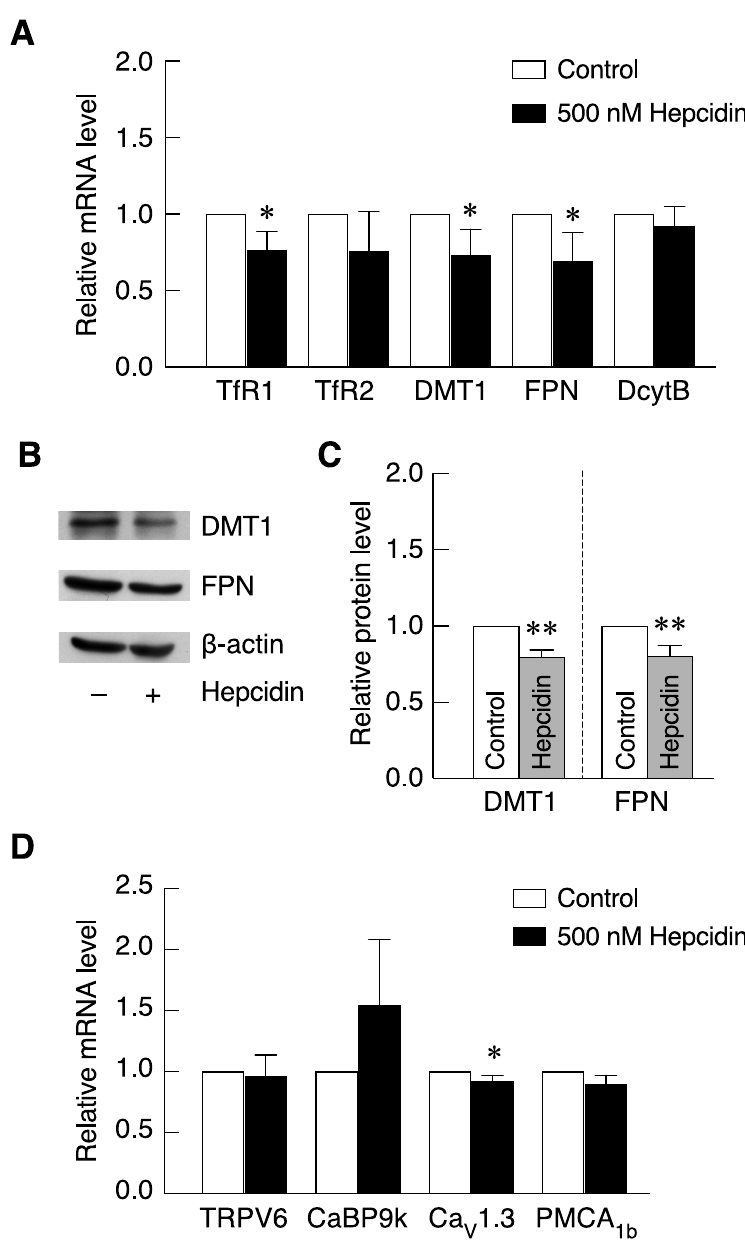
Fig 3. Hepcidin decreased DMT1 and FPN at mRNA and protein level but did not alter most calcium transporter and calcium binding protein expression at mRNA level. mRNA and protein expression of iron transporter and iron transport-associated proteins in Caco-2 cells after exposed to 500 nM hepcidin for 24 hours. ( A ) mRNA level was investigated by qRT-PCR and normalized by GAPDH and control groups (n = 3). ( B ) DMT1 and FPN protein expression was determined by western blot and normalized by β -actin, and ( C ) The quantitative data of protein band intensity was measured by Image J (n = 5). ( D ) The expression of calcium transporter and calcium binding protein was determined by qRT-PCR after exposed to 500 nM hepcidin for 24 hours (n = 3). Experiments were performed in three biological replicates each with three internal technical repeats for qRT-PCR experiments and five biological replicates for western blotting. P -value was calculated using one-tailed Mann-Whitney U Test. � P < 0.05, �� P < 0.01 as compared to control group.